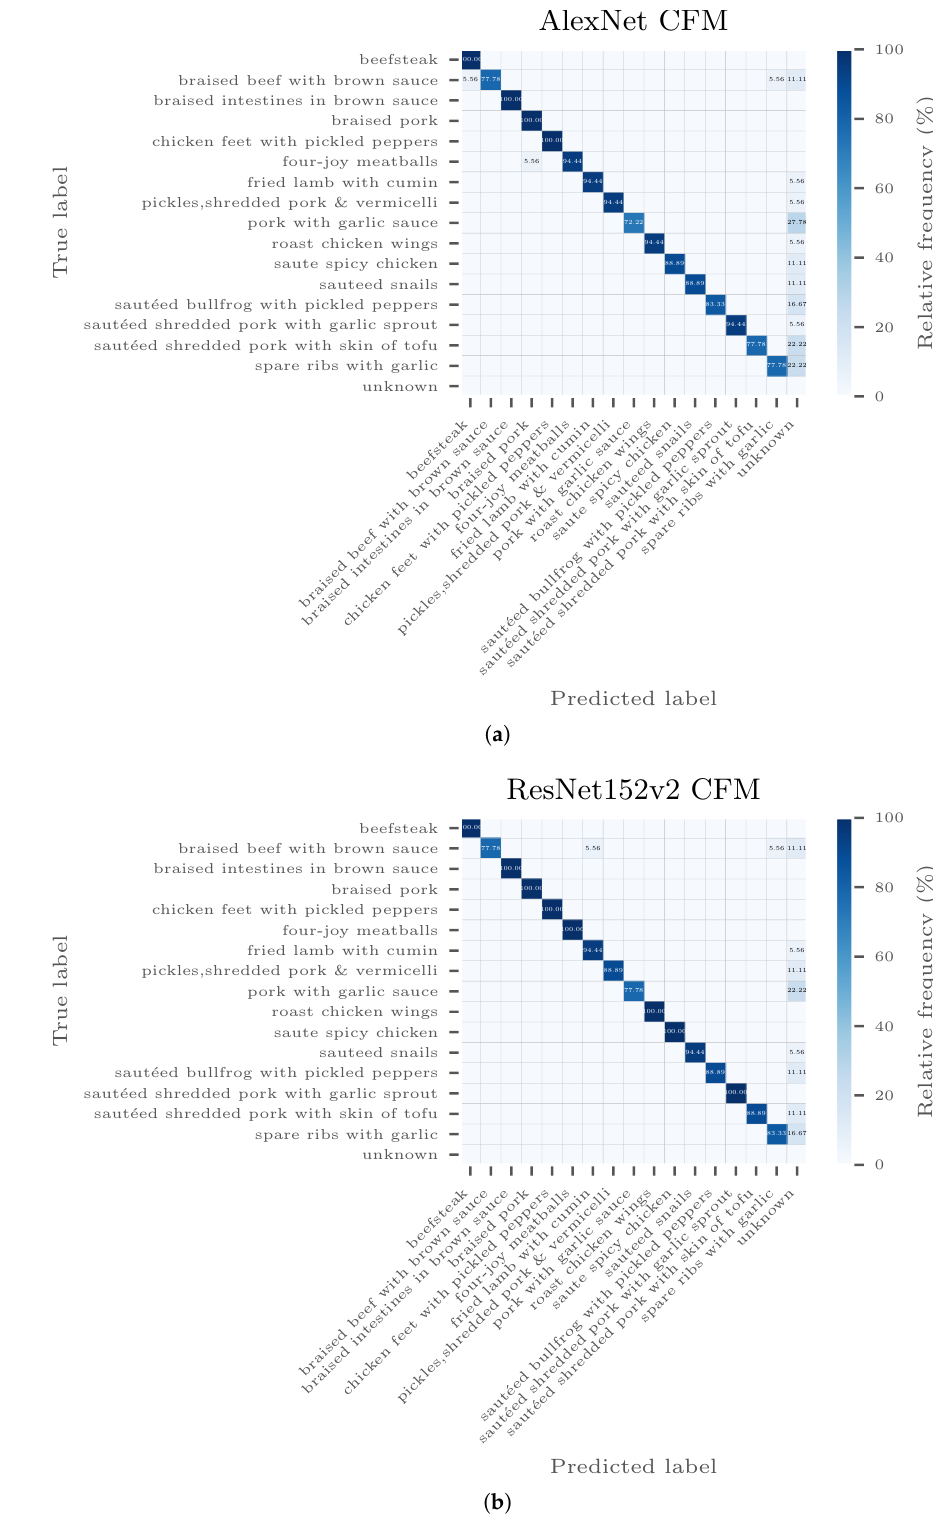
CFMs for AlexNet and ResNet deep neural networks are shown in Figure A6.